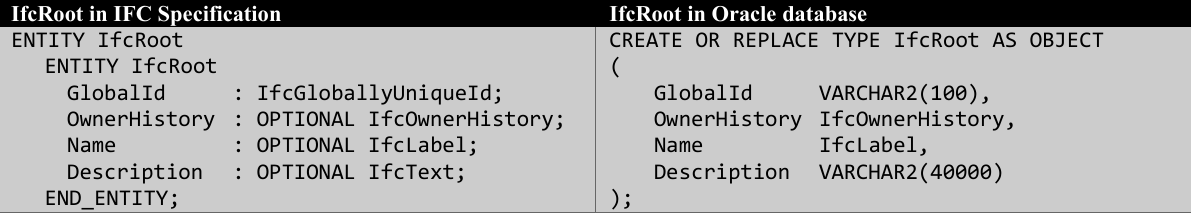
Table 2. Mapping of IfcRoot from IFC to Oracle